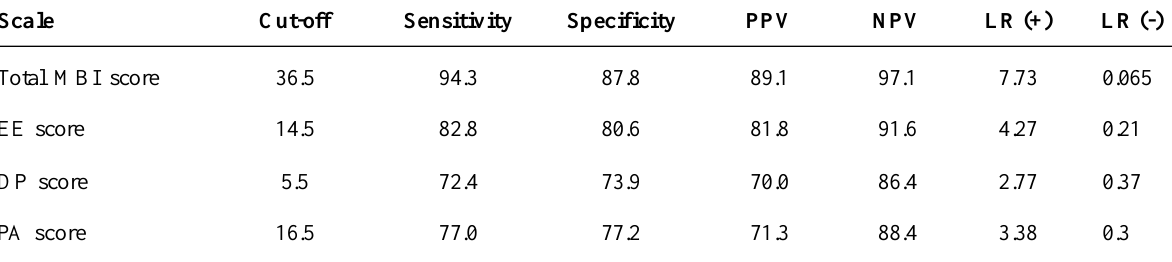
Table 2. Indicators of validity of the Maslach Burnout Inventory – Human Services Survey and its